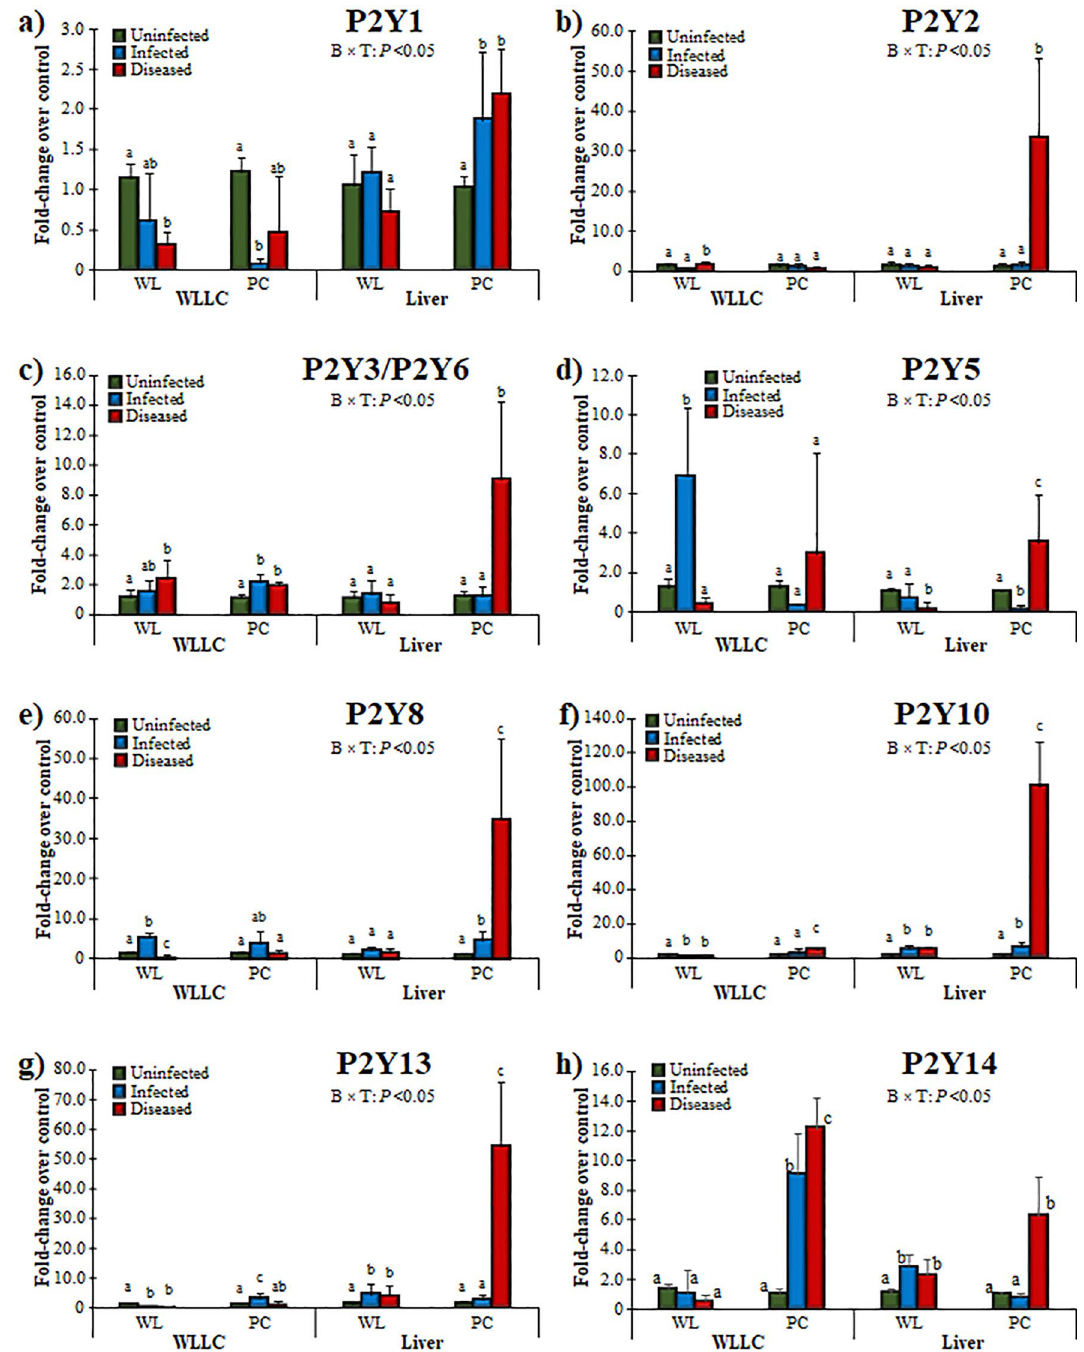
Figure 5. Relative mRNA expression of P2Y PRs in the MD-resistant (WL) and -susceptible (PC) chicken lines. PR expression was measured in WLLC and liver samples using RT-qPCR and fold-changes compared to uninfected controls is shown for P2Y1 ( a ), P2Y2 ( b ), P2Y3/P2Y6 ( c ), P2Y5 ( d ), P2Y8 ( e ), P2Y10 ( f ), P2Y13 ( g ), and P2Y14 ( h ). Data and statistics are presented as in Fig.